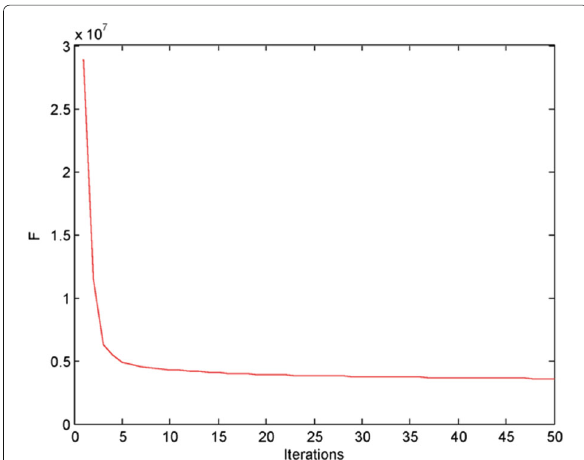
Fig. 4 Energy functional values in the iterations